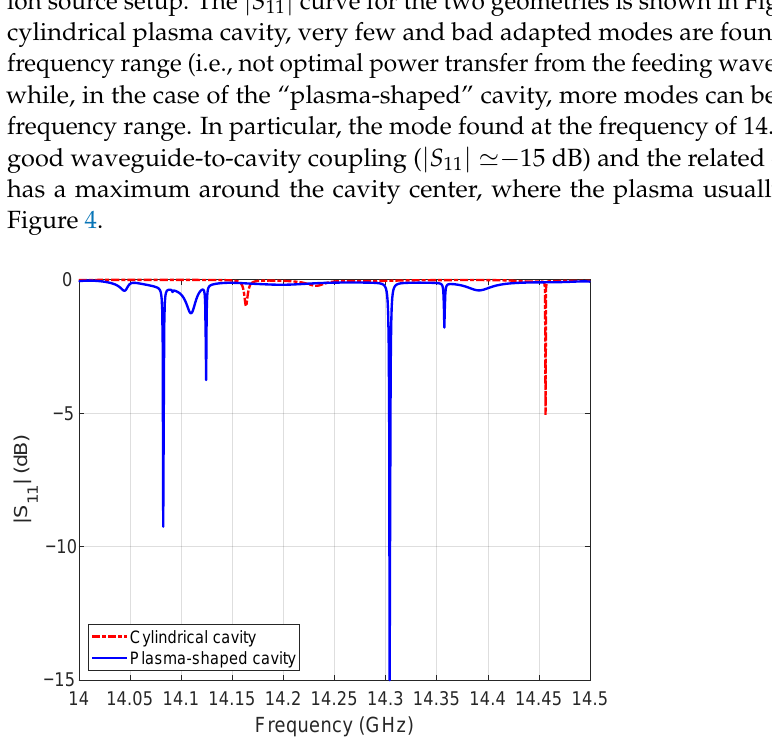
Figure 3. | S 11 | curve, inside the operational bandwidth of 14–14.5 GHz, for the standard cylindrical cavity and the “plasma-shaped”